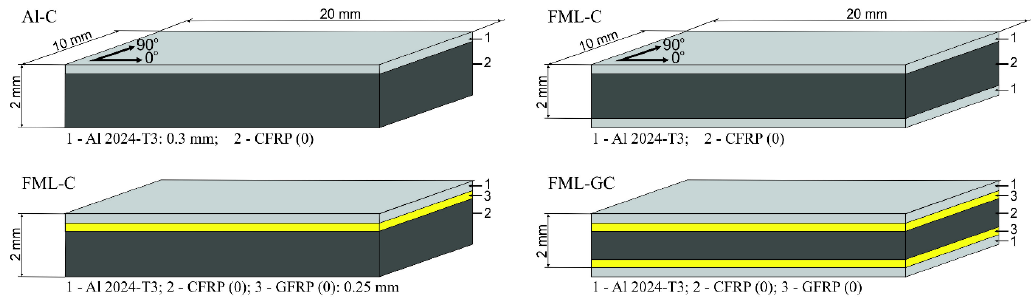
Figure 1. The configurations of the tested laminates.